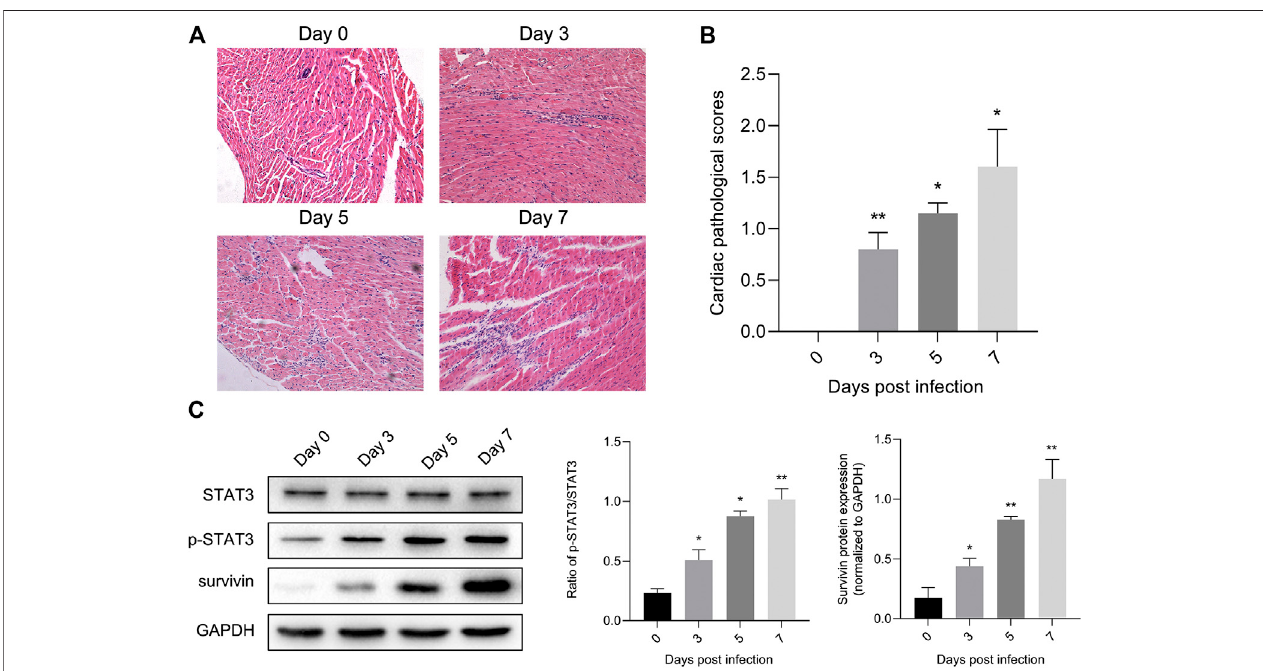
FIGURE 1 | STAT3 was activated in viral myocarditis animal model. Mice were injected intraperitoneally with CVB3 and hearts were collected at designated time points (A) Cardiac damage was quanti fi ed on hematoxylin and eosin staining ( n (cid:2) 4, 200 × ) (B) The cardiac pathological scores in different groups ( n (cid:2) 4) (C) The related proteins were measured by western blot ( n (cid:2) 4). * p < 0.05, ** p < 0.01 vs control group (NC).